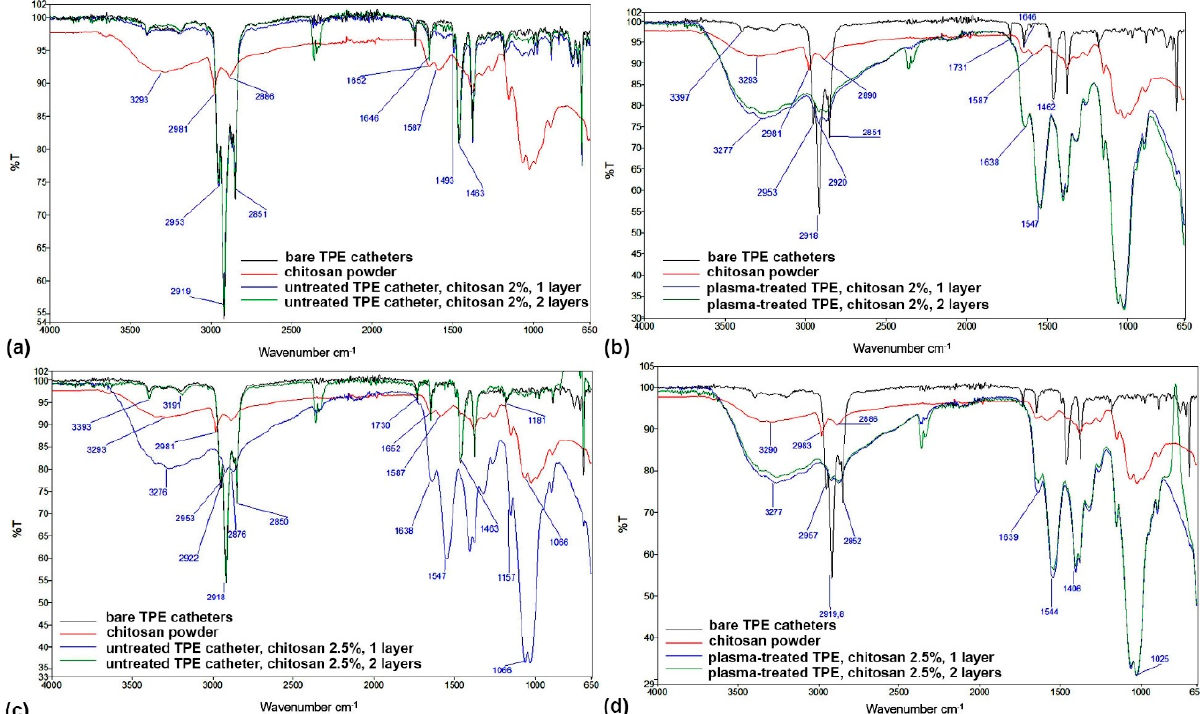
Figure 11. FTIR spectra of TPE catheters with chitosan coatings: ( a ) untreated catheter with one or two layers of the 2% chitosan coating, ( b ) plasma-treated catheter with one or two layers of the 2% chitosan coating, ( c ) untreated catheter with one or two layers of the 2.5% chitosan coating and ( d )